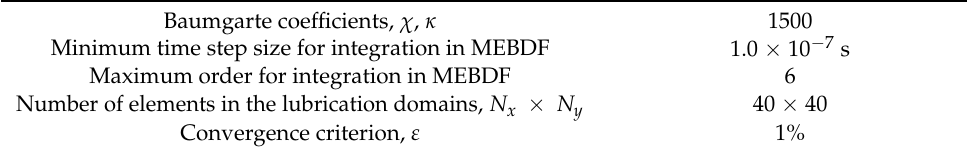
Figure 7. The supply pressure inside the cylinder chamber. Table 2. Simulation parameters for the